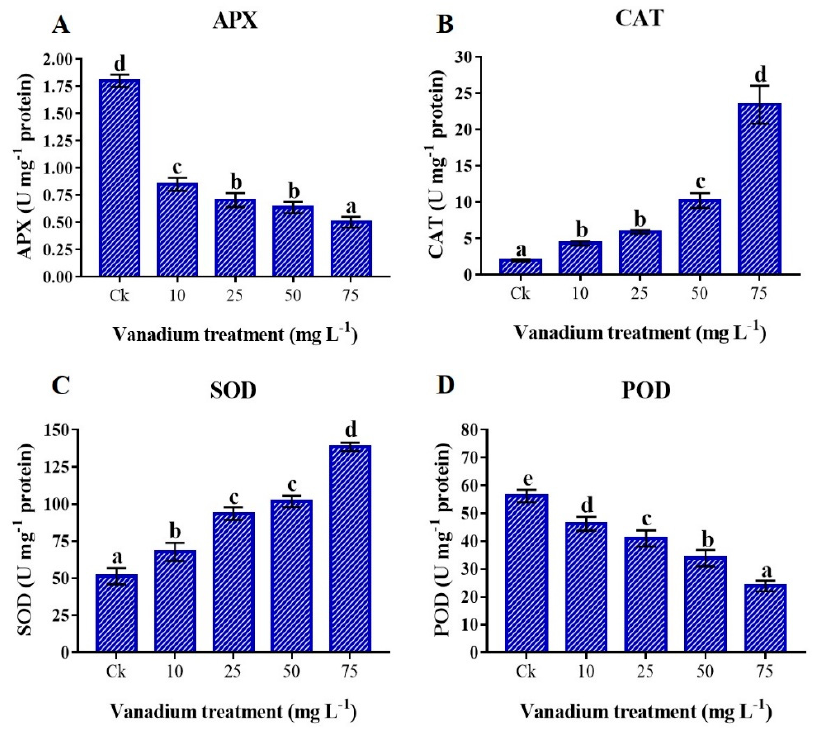
Figure 8. Influence of various V treatments on the antioxidant enzymes activities in the leaves of sweet potato. ( A ) APX, ( B ) CAT, ( C ) SOD, and ( D ) POD. Duncan’s test indicates a significant difference ( p < 0.05) between the means of the five treatments indicated by different alphabetical letters.